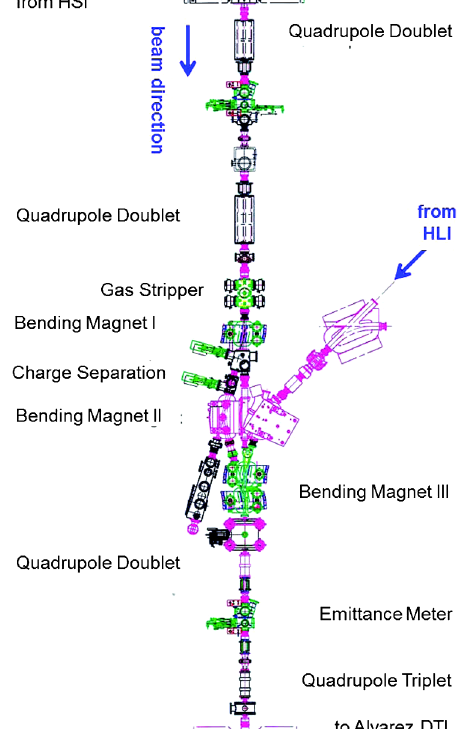
FIG. 1. Layout of the 1 . 4 MeV = u stripper section; 14.0 m total length.